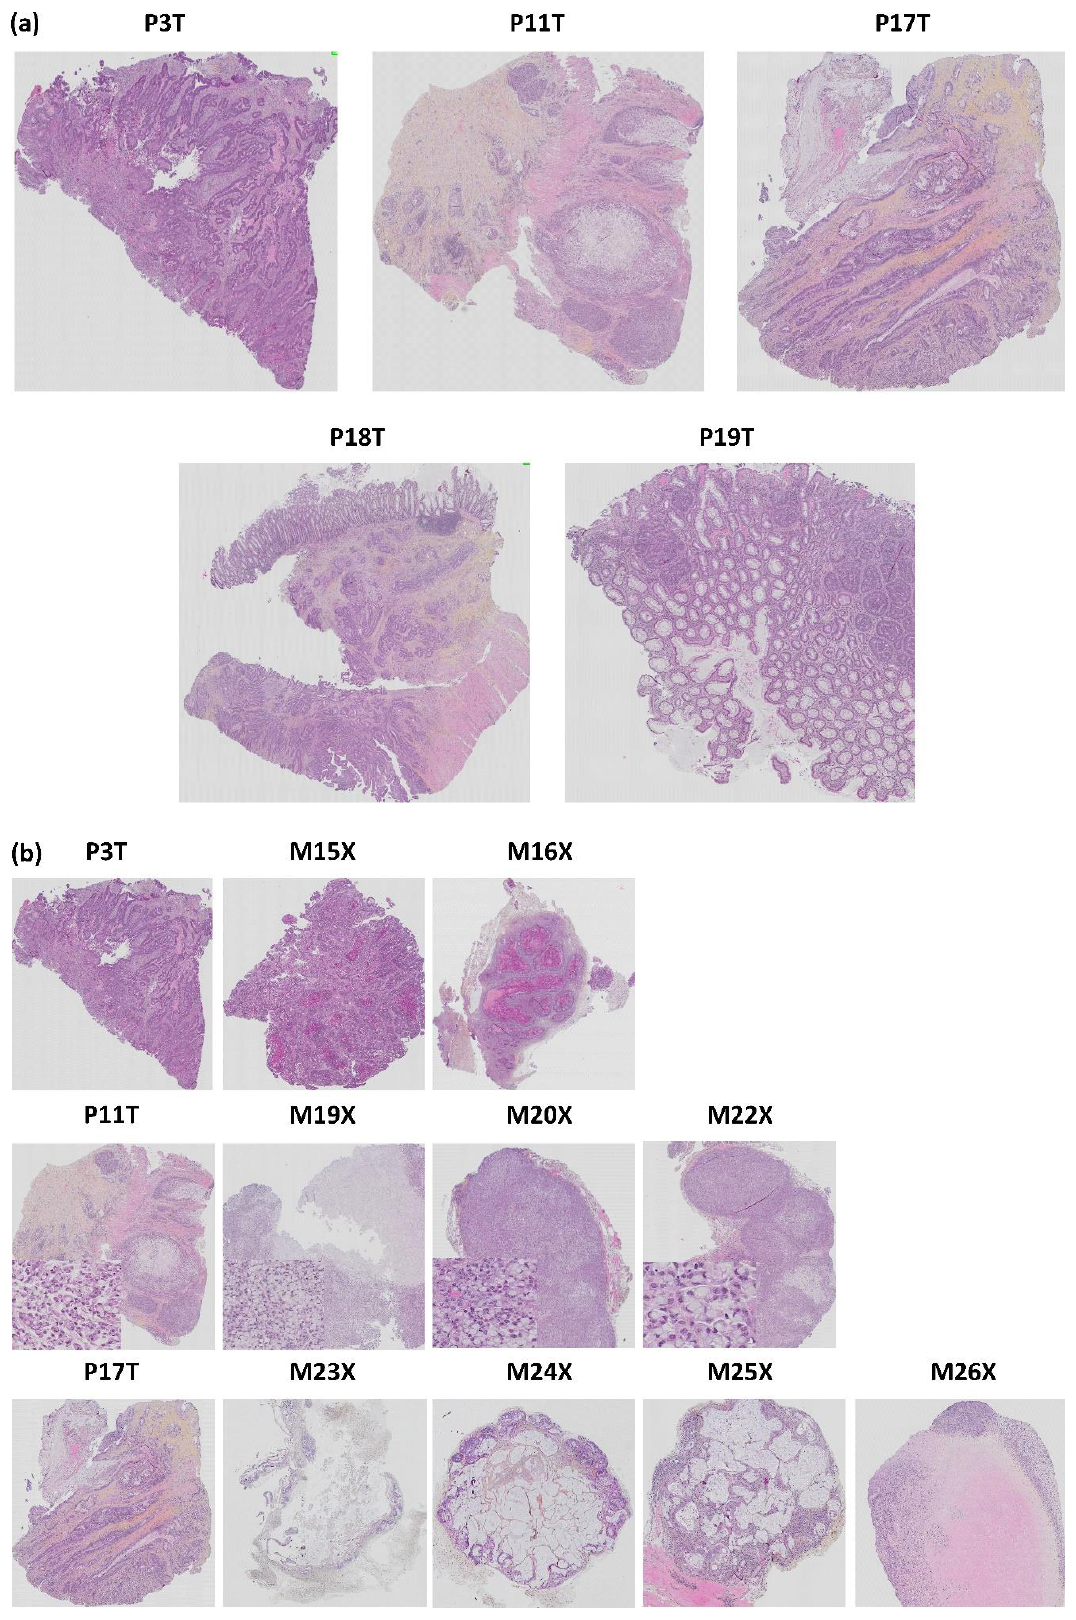
Figure 12. Histopathological comparison of: ( a ) the five patient CRC tumors and ( b ) three patient tumors and matched PDX tissue sections. The tissue sections are stained with HES. p = patient, T = tumor, M = mouse, X = xenograft.